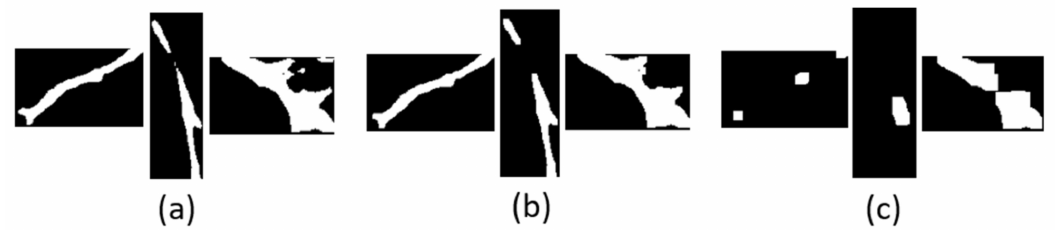
Figure 6. Processing results using convolution kernels of different sizes. ( a ) The processing results of morphological opening operation when convolution kernel is 1 × 1; ( b ) the processing results of morphological opening operation when convolution kernel is 5 × 5; ( c ) the processing results of morphological opening operation when convolution kernel is 10 × 10.